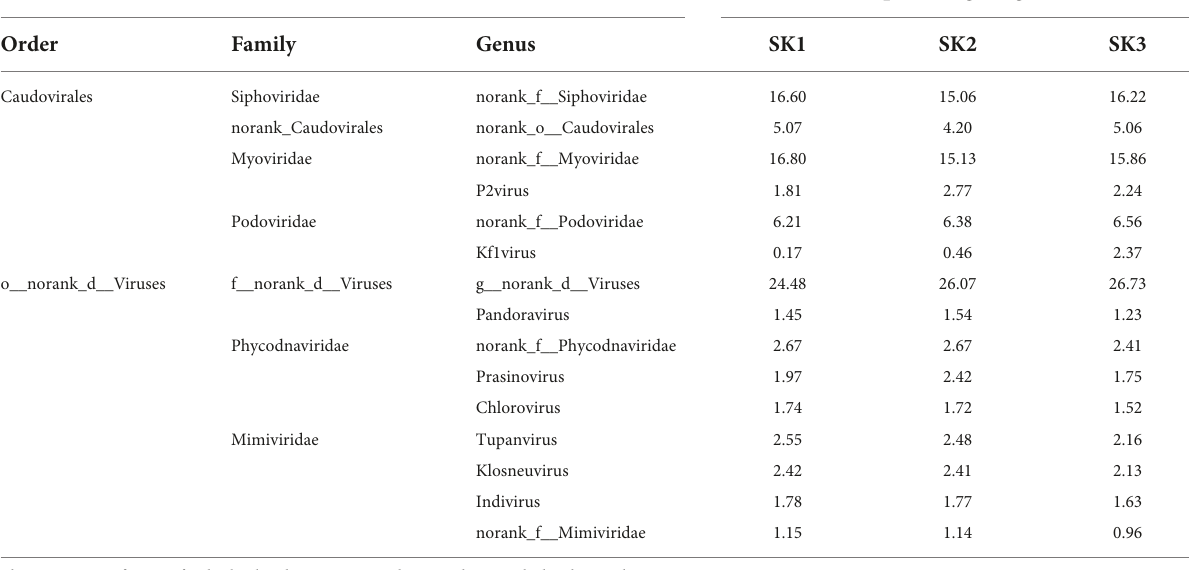
TABLE 4 Transcripts per million (TPM) abundance percentage of samples at the genus level.